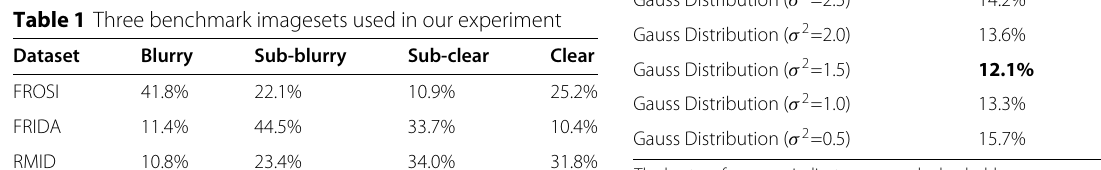
Experiments Implementation detail